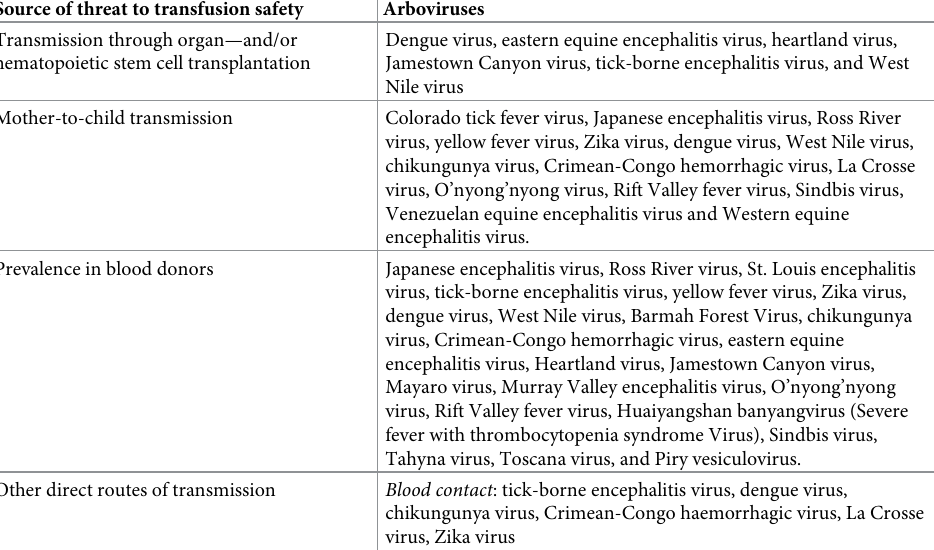
Table 4. Arboviruses that could pose a threat to transfusion safety due to direct non-vector related transmission